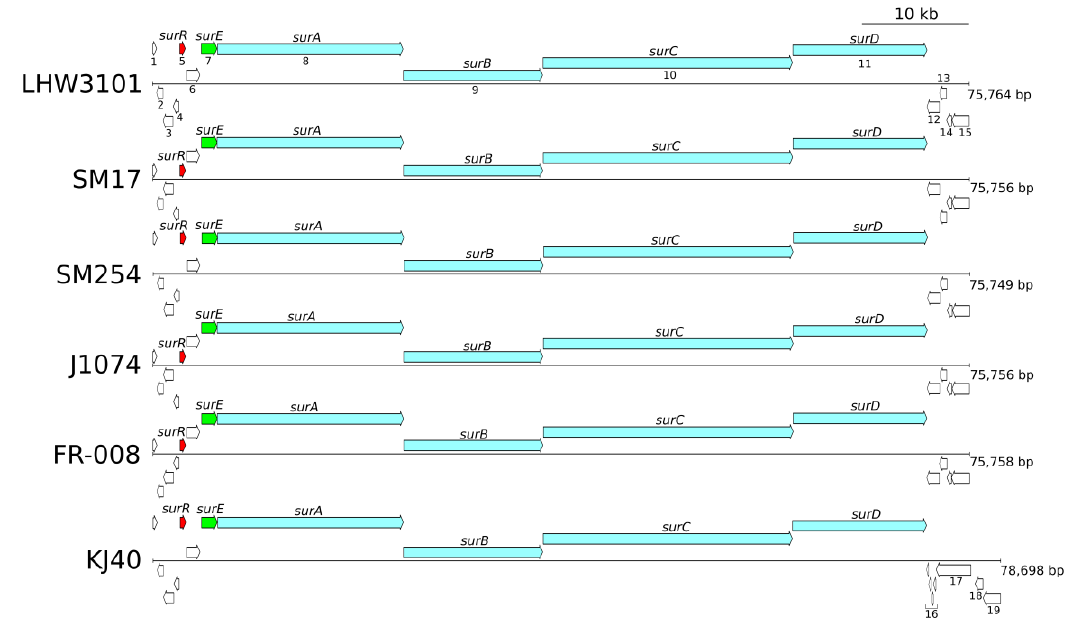
Figure 6. Gene synteny of the sur BGC region, including the reference sur BGC nucleotide sequence (LHW3101) and each of the albidoflavus phylogroup genomes. Arrows at different positions represent genes transcribed in different reading frames.